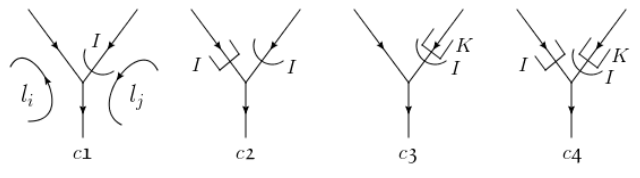
Figure 43. The four possibilities of net approximations, whose associated pinch surfaces are nested with (cid:12)gure 40( c ), using N (cid:27) ( l j ) = N (soft) m